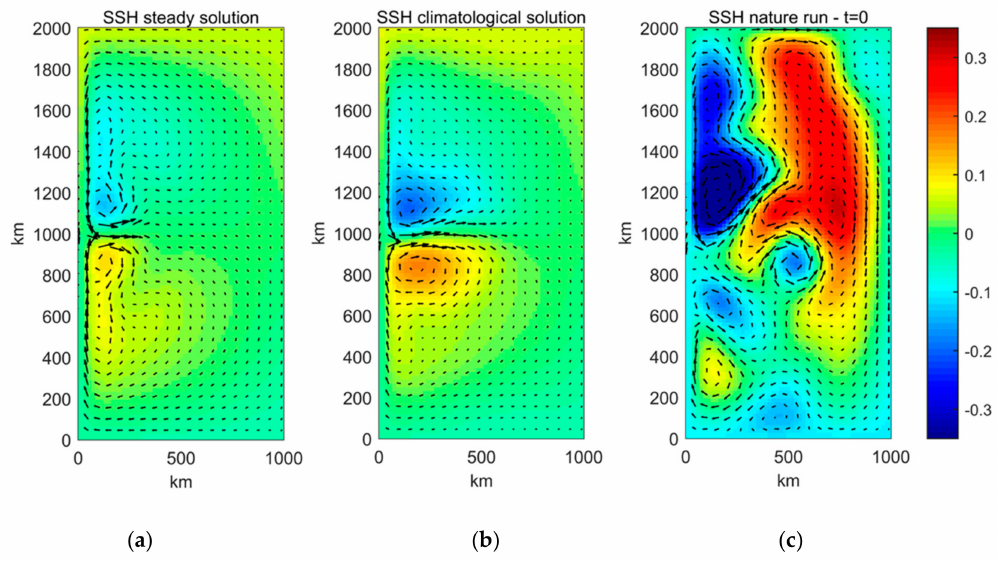
Figure 1. Surface current field (arrows) and Sea Surface Height (SSH) (m) of ( a ) the steady solution, ( b ) the climatological state, and ( c ) the initial state of the Nature Run for the first assimilation